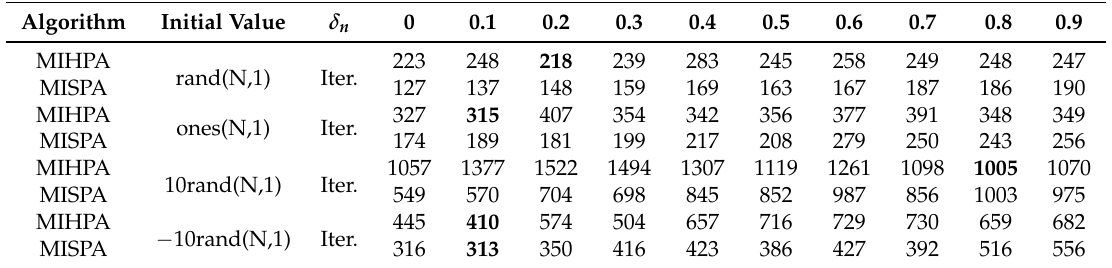
Table 1. Computational results for Example